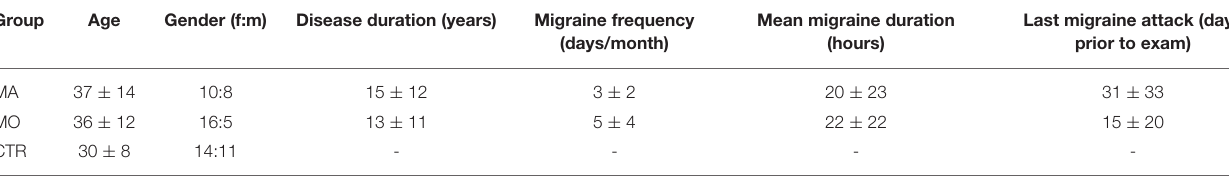
TABLE 1 | Summary of patient